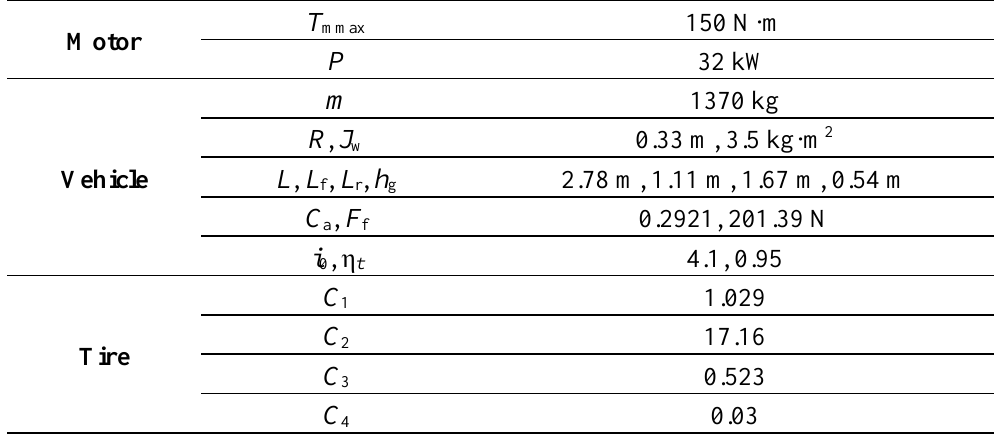
Table 3. Simulation